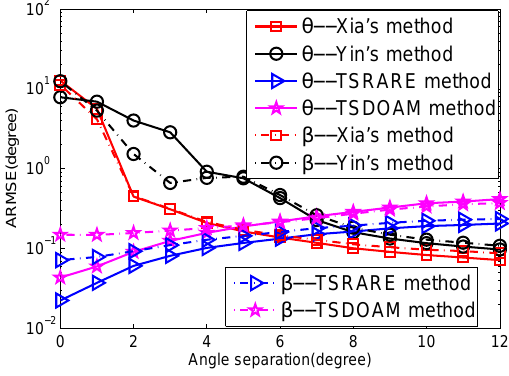
Figure 5. The ARMSE versus angular